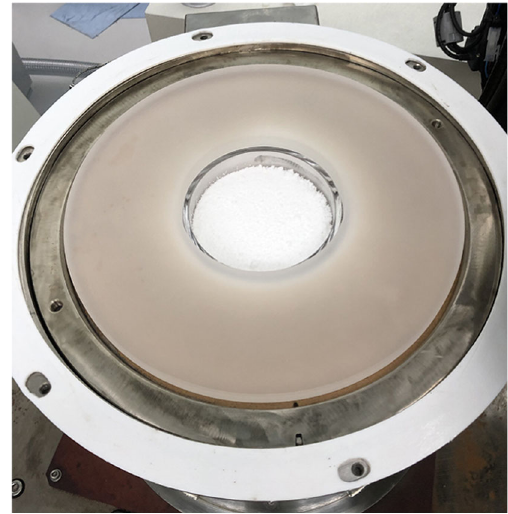
Fig. 2 A top view of the grower with NaI powder loaded in the middle crucible,withthechambercupolaremoved.Ahollow-disk-shapequartz lid covers the top of the refractories to prevent fumes from coming out when heated